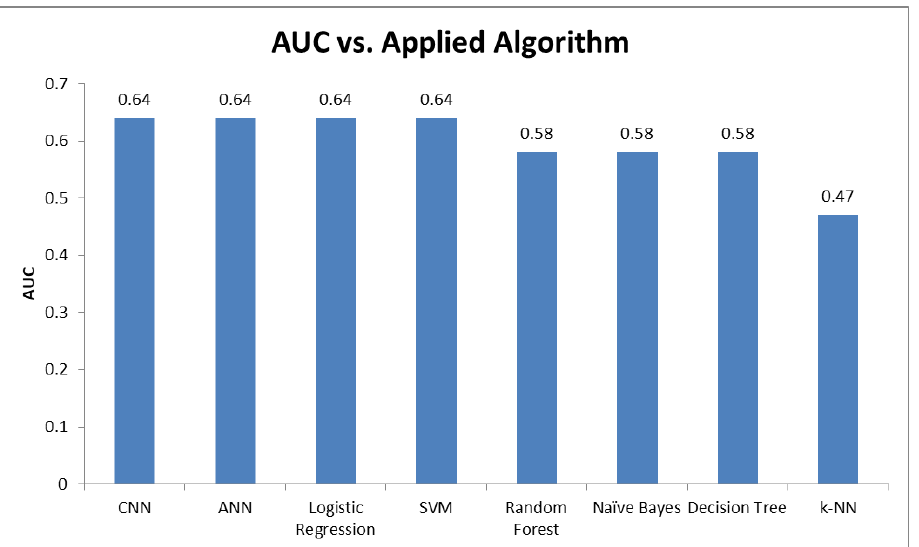
Figure 10. The AUC vs. the applied